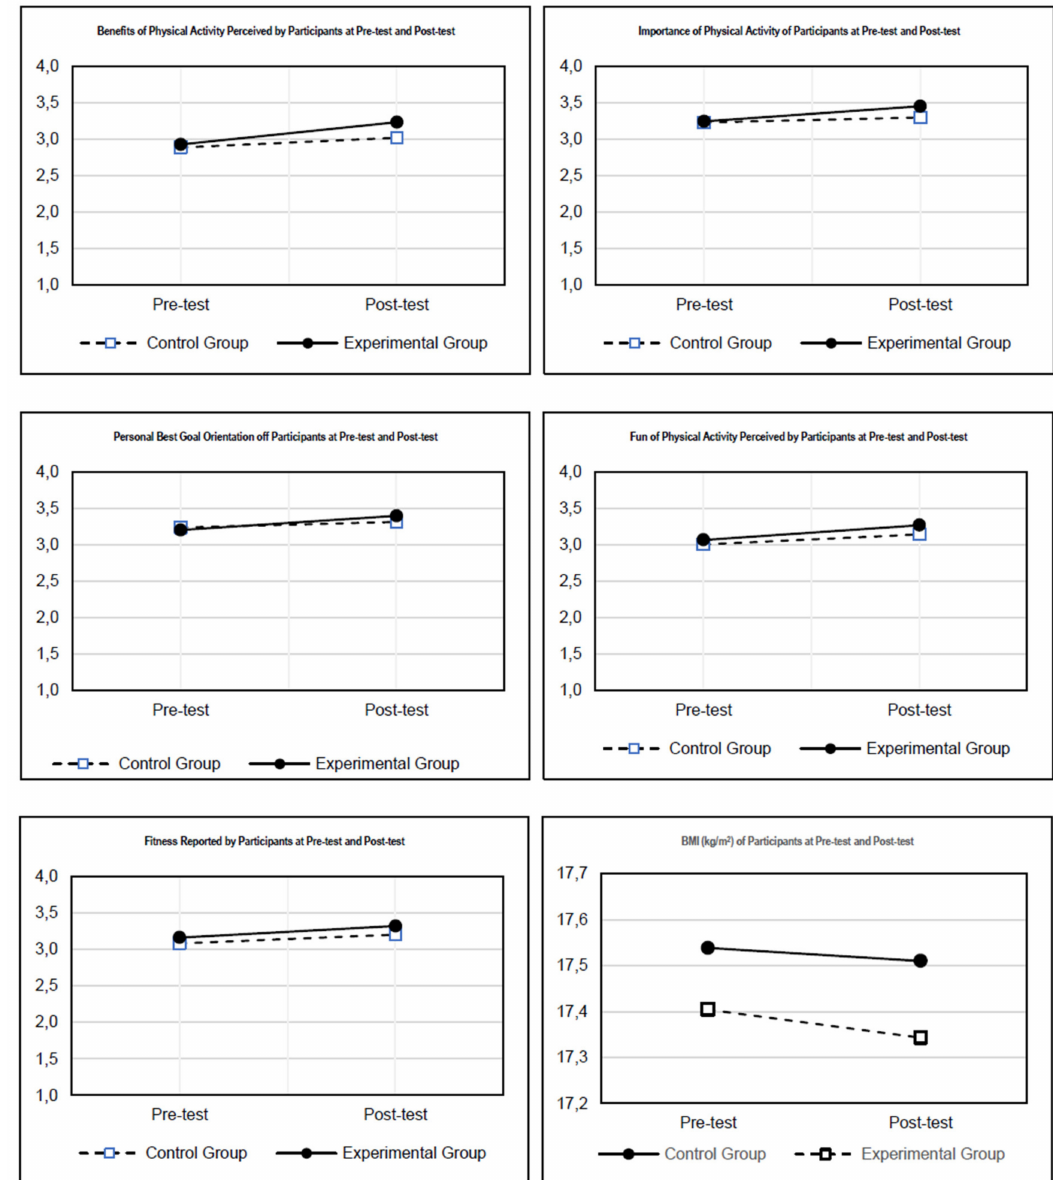
Figure 1. Distribution of the APAS scales’ means for the control and experimental groups (pre-test and post-test). Significant di ff erences (* p ≤ 0.05) were found between the control and experimental groups for self-e ffi cacy, learning, benefits, importance, personal best, and fun at the post-test (significance order is largest to